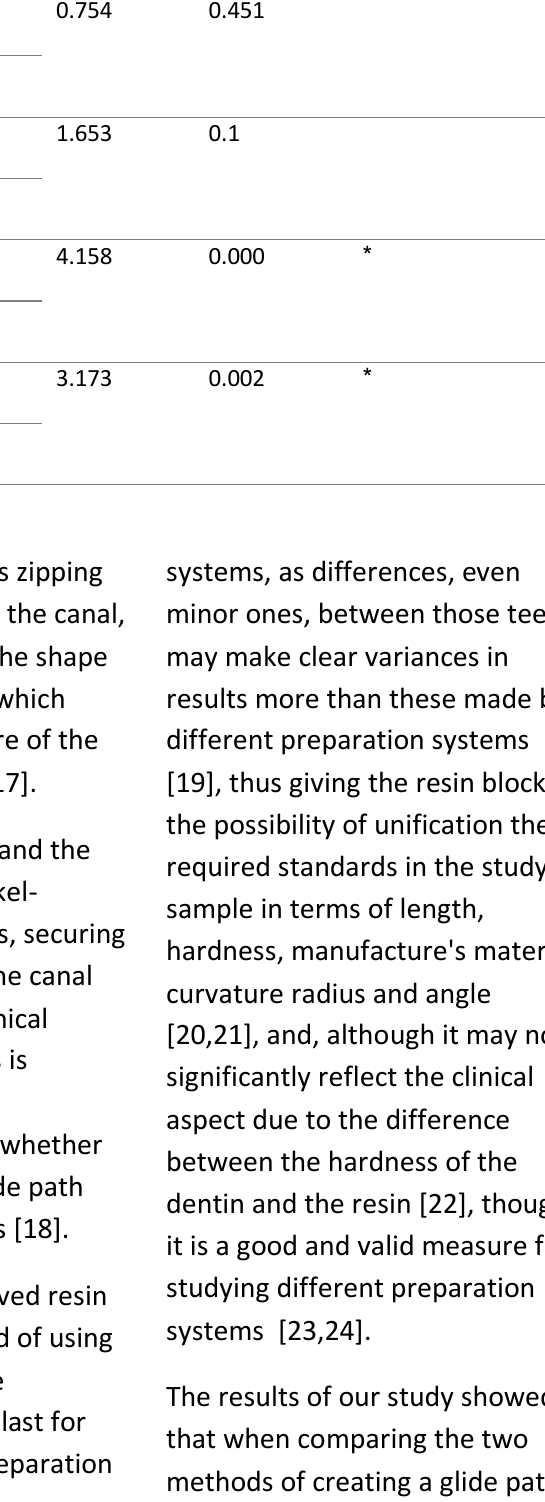
Table 4: the rate of preserving the canal centric after glide path Variables N Mean Significance Apical curvature